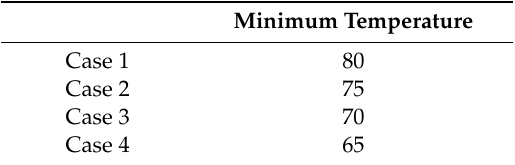
Table 5. Minimum supply temperature.